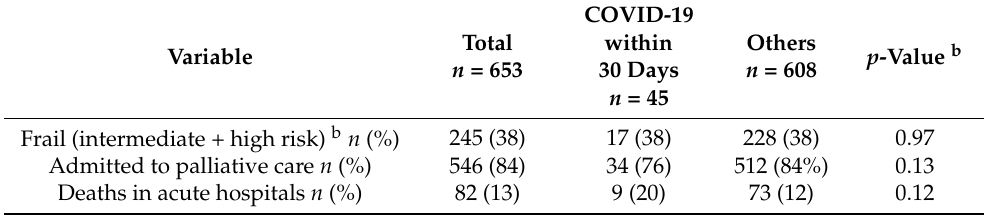
Table 5. Frailty, palliative care, and place of death of patients with advanced lung cancer a ( n = 653). COVID-19 Others within Total Variable p -Value b n = 608 n = 653 30 Days n = 45 Frail (intermediate + high risk) b n (%) 245 (38) 17 (38) 228 (38) 0.97 Admitted to palliative care n (%) 546 (84) 34 (76) 512 (84%) 0.13 Deaths in acute hospitals n (%) 82 (13) 9 (20) 73 (12)